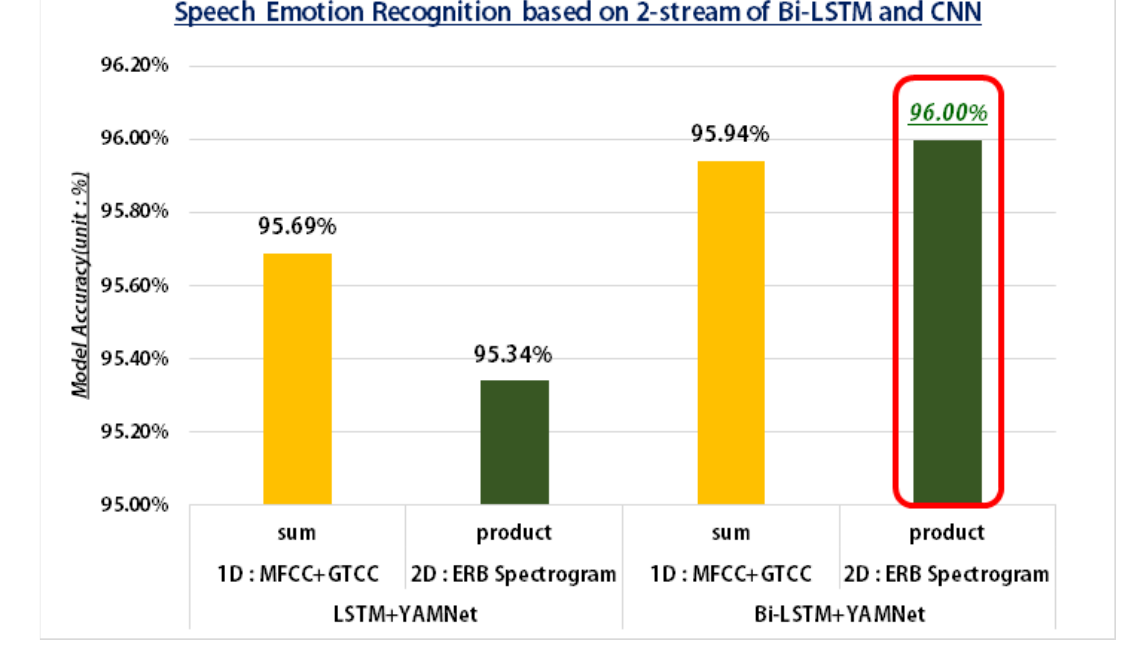
Figure 10. Accuracy of Bi-LSTM and CNN two-stream-based SER model.